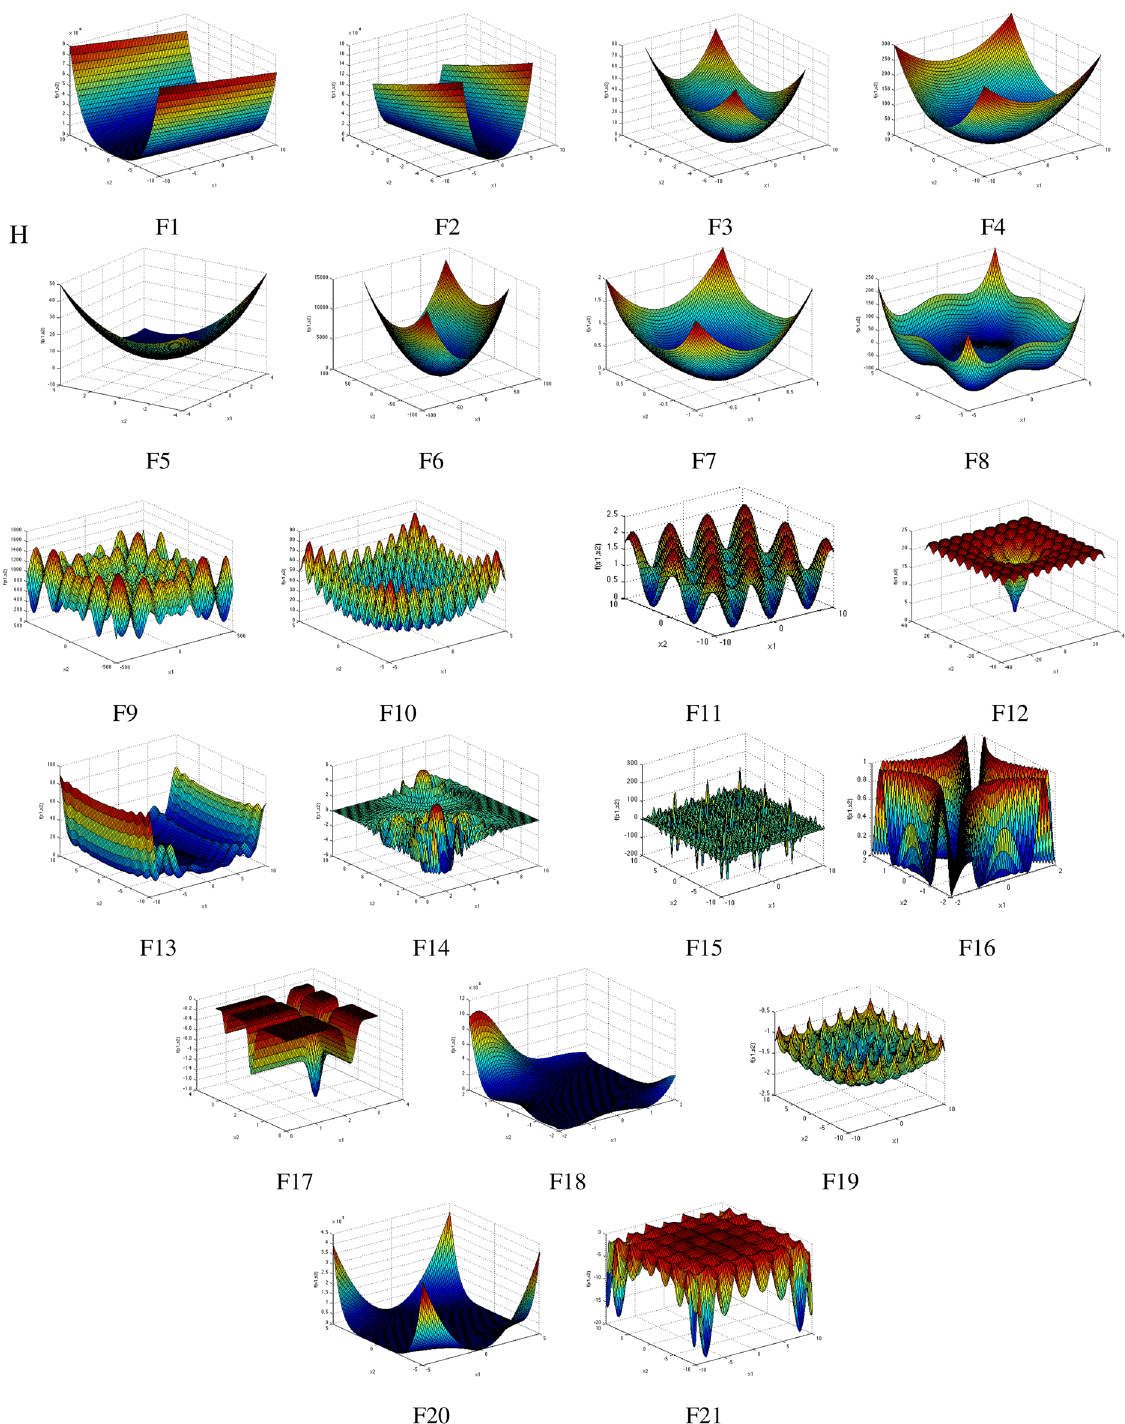
Figure 3. 2-D Representation of benchmark